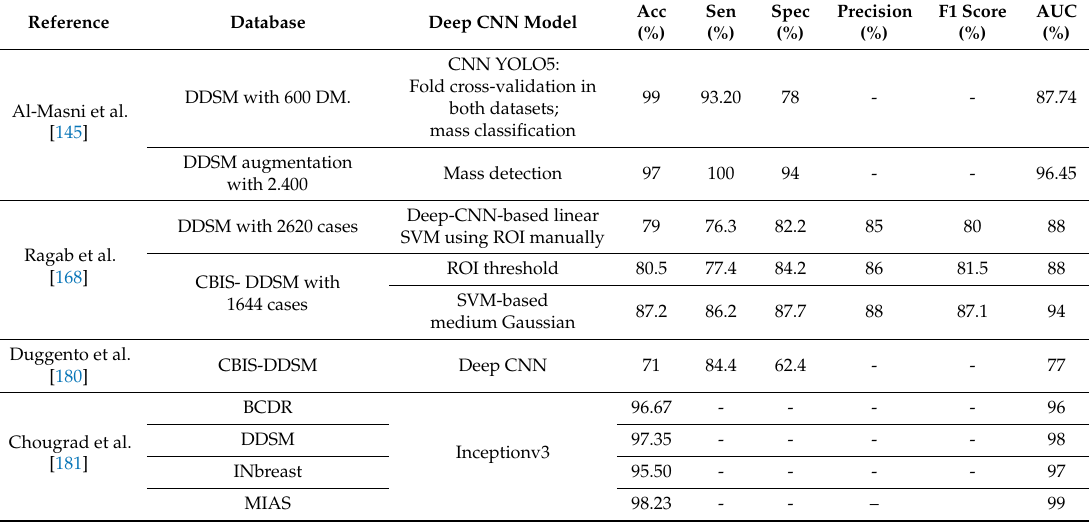
Table 6. The quantitative indicators that were used to evaluate the performance between di ff erent CNN architectures in DM